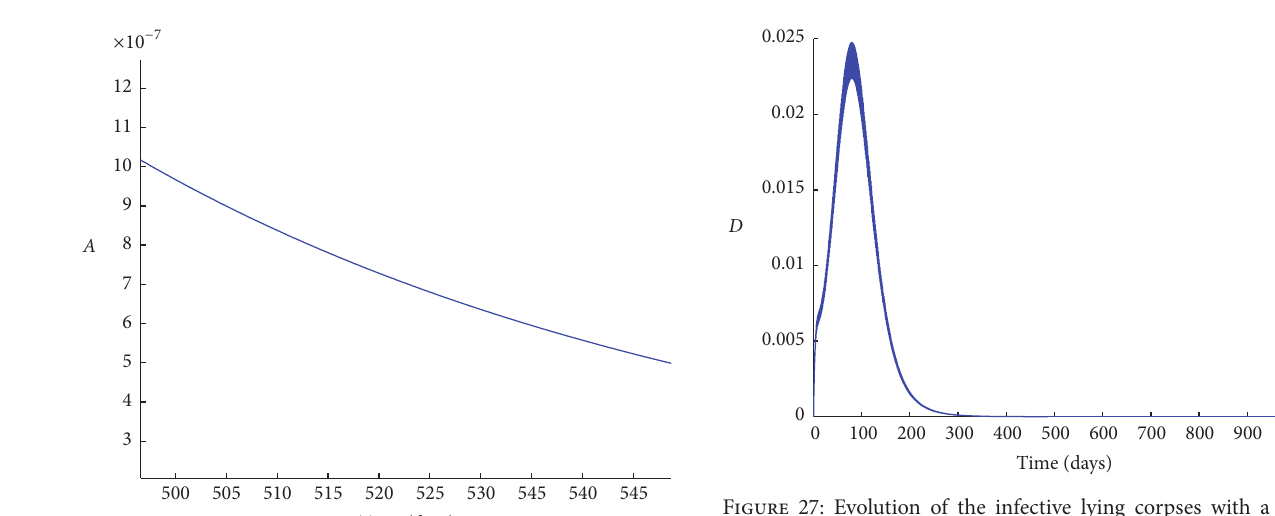
Figure 27: Evolution of the infective lying corpses with a daily culling rate of 𝜌 𝐷 = 0.1 .